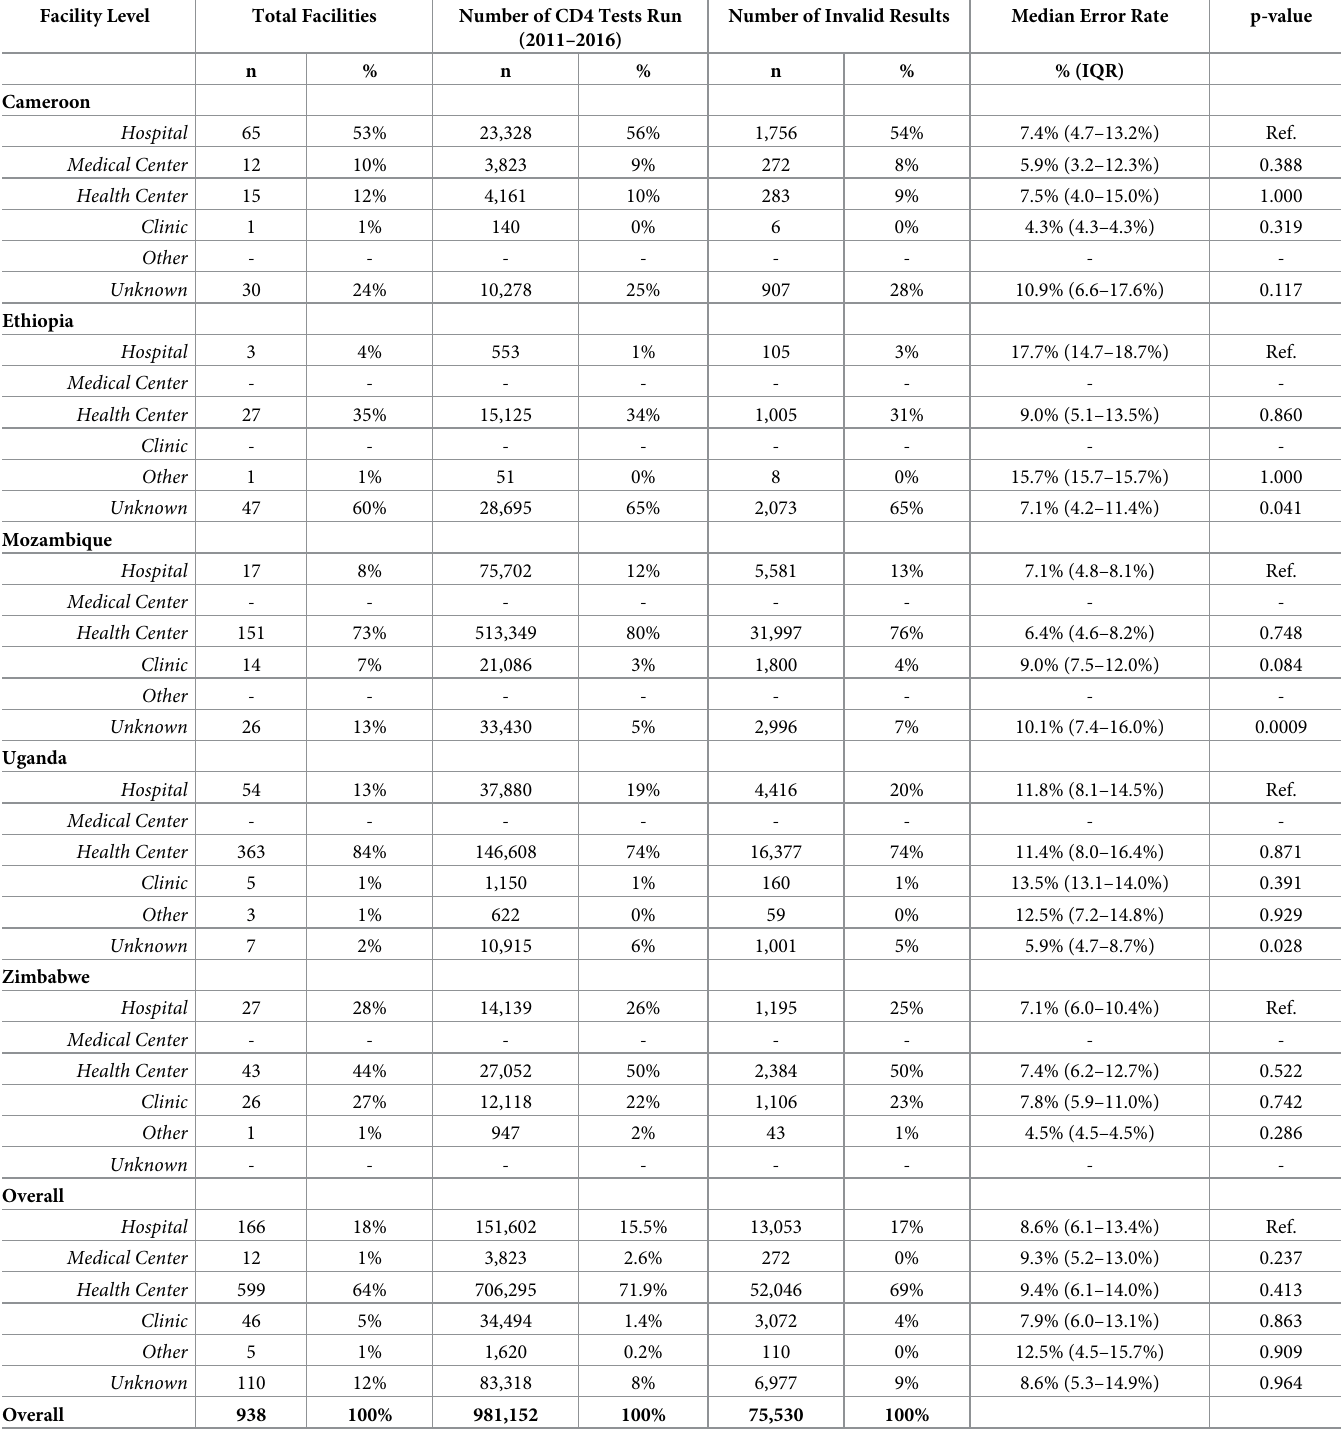
Table 3. Total tests run and invalid results and rates by health care facility type per country. Facility